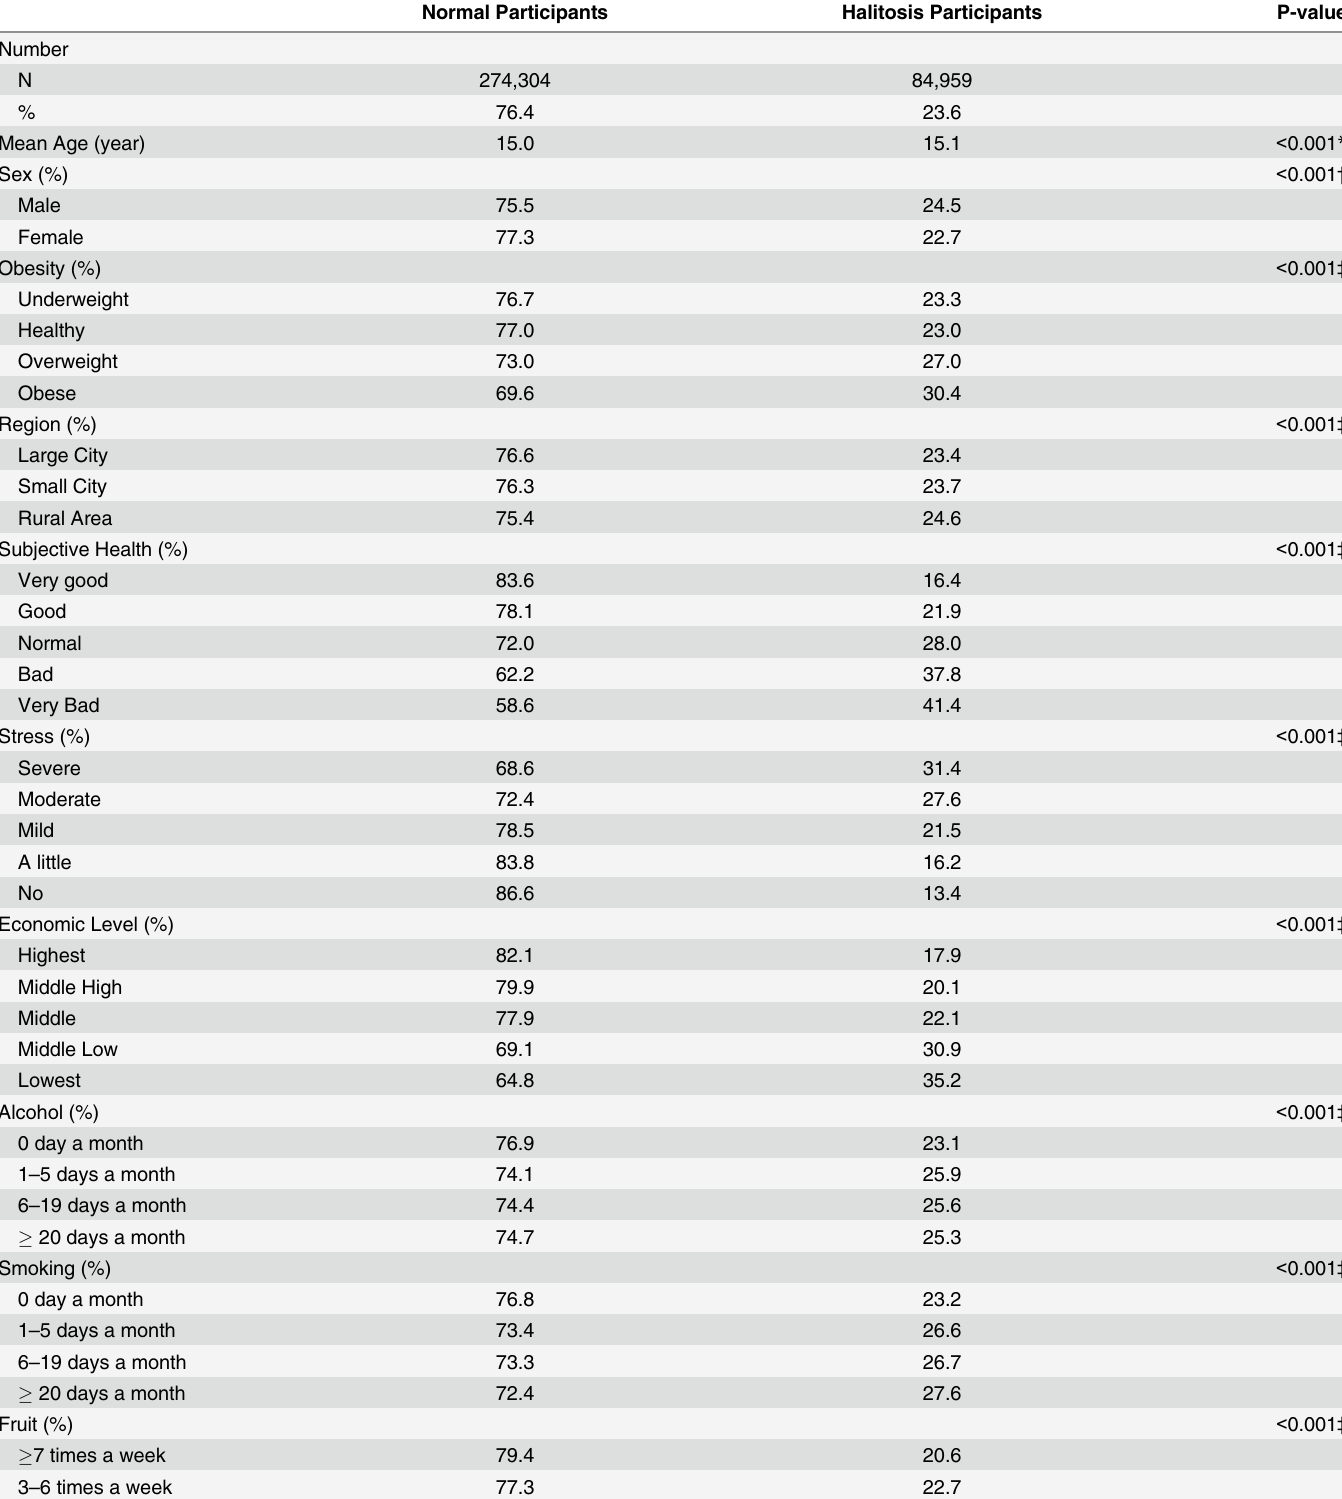
Table 1. General Characteristics of Halitosis and Normal